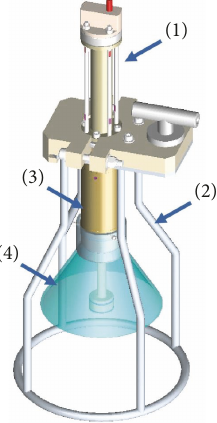
Figure 3: Picture of the PEGAZ gas-bubble sampler: (1) triggering system, (2) chassis, (3) high-pressure cylinder, and (4)